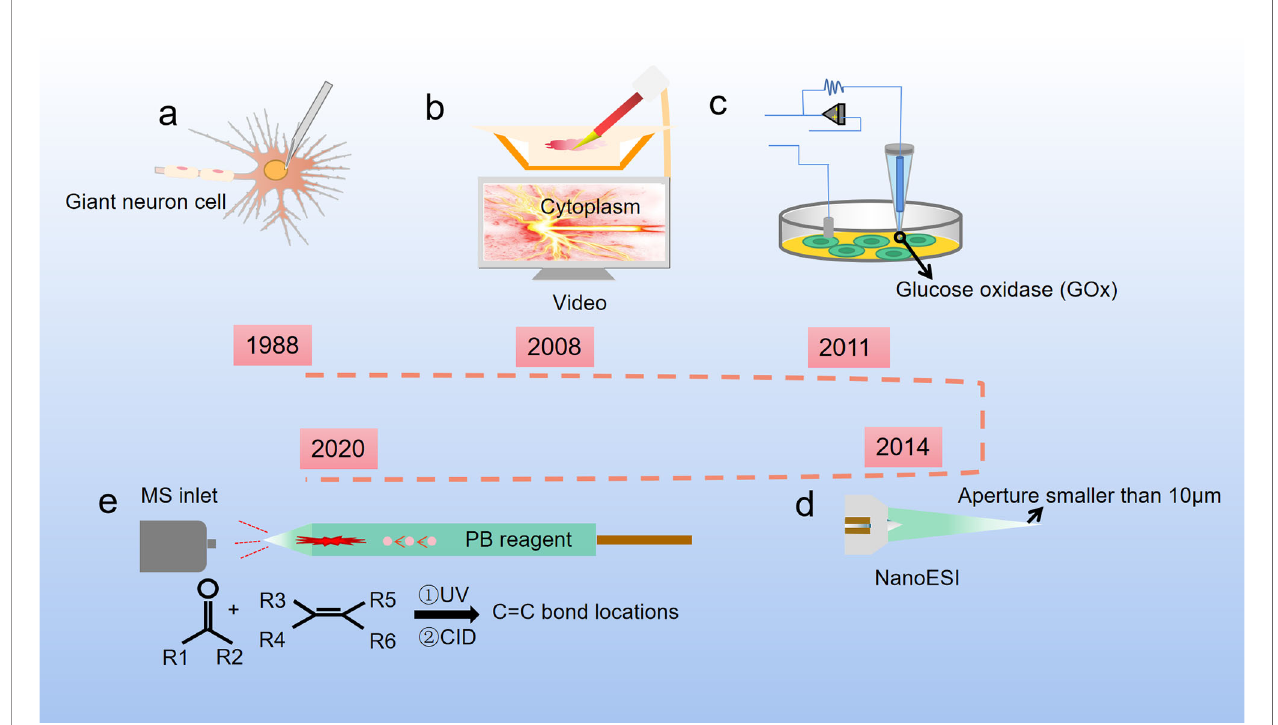
FIGURE 2 | Development of single cell metabolite extraction. (A) Microsyringes composed of glass straws were fi rstly used to extract metabolites from giant neuron cells of snails (1988); (B) Nanospray ionization captures the sample from a single living cell, and this process is controlled by a cell manipulation system (2008); (C) A nanotube that can measure glucose levels in single-cell level (2011); (D) The Single-probe coupled with a sampling tip size < 10 m m, is a miniaturized multifunctional sampling and ionization tool which can achieve in situ metabolomic analysis of individual living cells with real-time performance (2014); (E) The micropipette needle accommodated with PB reactions inside to determine C=C bond locations in unsaturated lipids at single-cell level